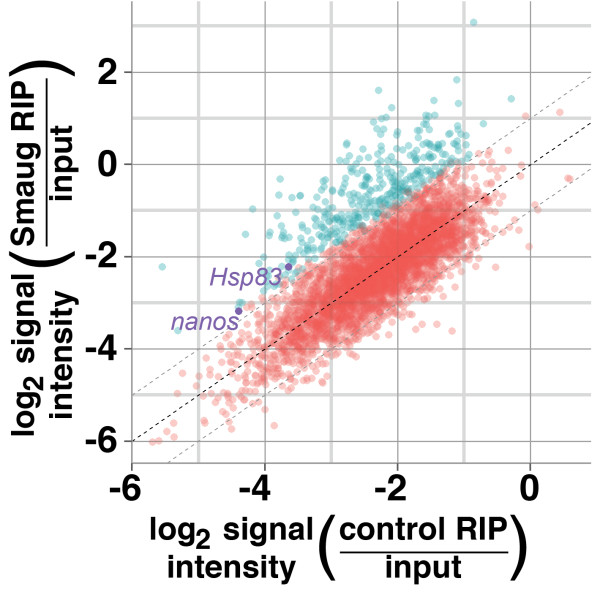
Identification of Smaug-bound mRNAs. The average, across three biological replicates and one technical replicate, of the microarray signal intensities of each expressed transcript in the Smaug and control RIPs divided by the signal intensities of each transcript in the immunoprecipitation inputs, were plotted against one another. SAM analysis allowed for the identification of 384 transcripts (blue dots) representing 339 genes that are enriched in the Smaug RIPs versus control RIPs at an FDR of <5%. The dots representing Smaug’s two known target mRNAs, nanos and Hsp83, are indicated. The dark dashed line represents no enrichment and the light dashed diagonal lines represent two-fold enrichment or depletion.